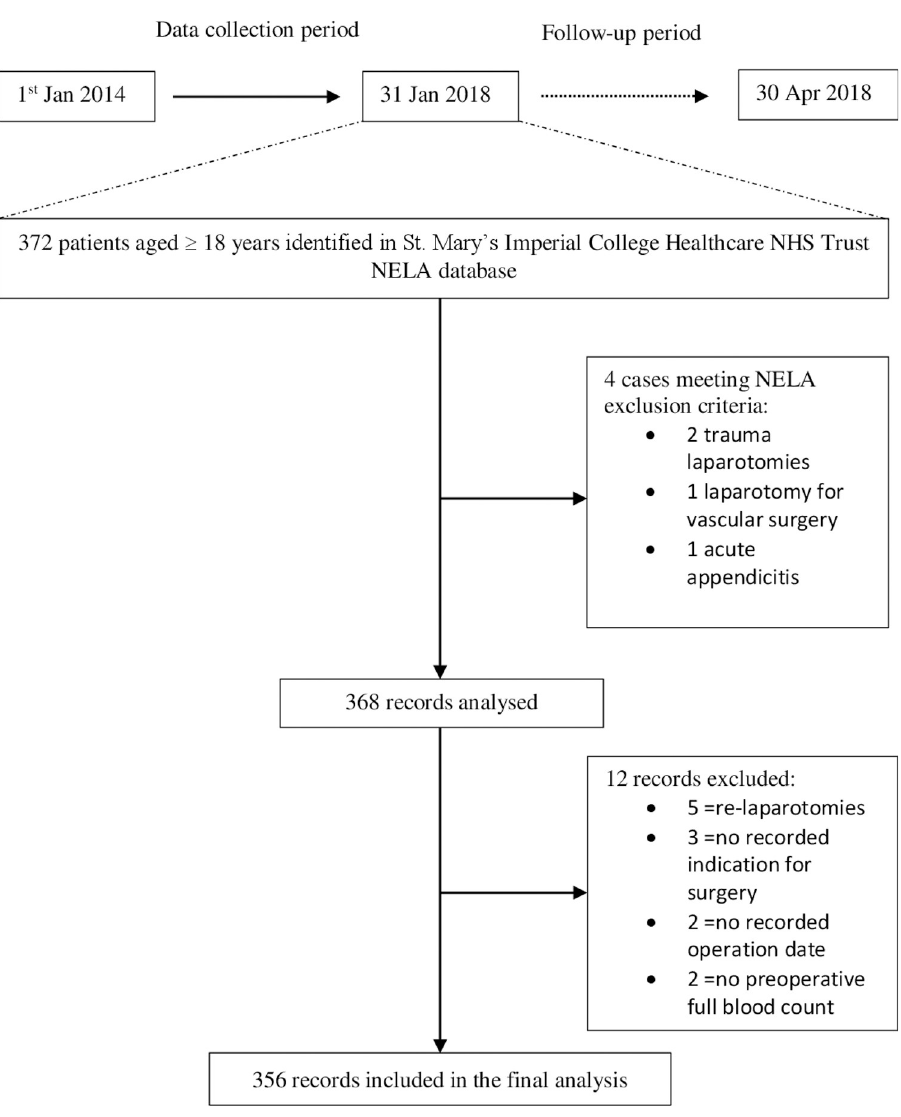
Fig 1. CONSORT diagram of patient